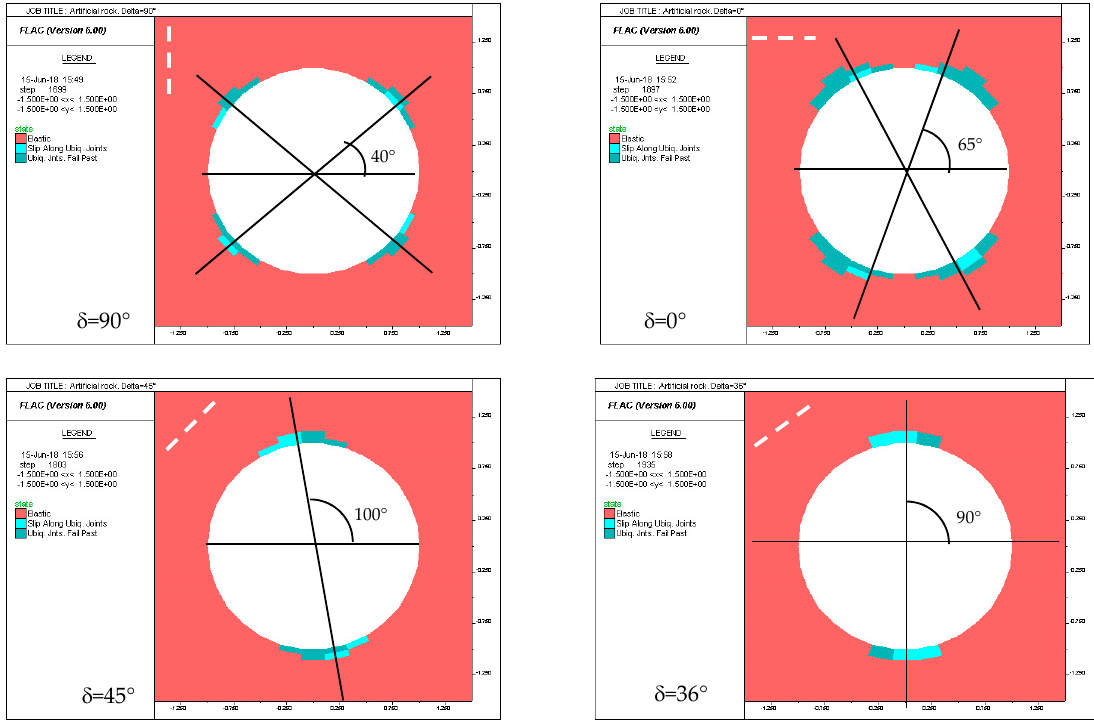
Figure 11. Slip failures obtained with the code FLAC (the turquoise color indicates slip along the ubiquitous joints at the convergence of the numerical runs, the red color indicates elastic behavior and the blue color indicates “at yield in past”, i.e., during the numerical convergence). Artificial rock: ϕ ’ w = 18° and c ’ w = 11 MPa, σ MAX = 45 MPa (horizontal direction), σ min = 35 MPa (vertical direction) and P f = 20 MPa. The out of plane stress used in FLAC is σ II = 40 MPa. The angles reported in the figure are the average azimuths ϑ , where the first slip occurs in the numerical simulations. The dotted white lines represent the inclination δ of the weakness planes.